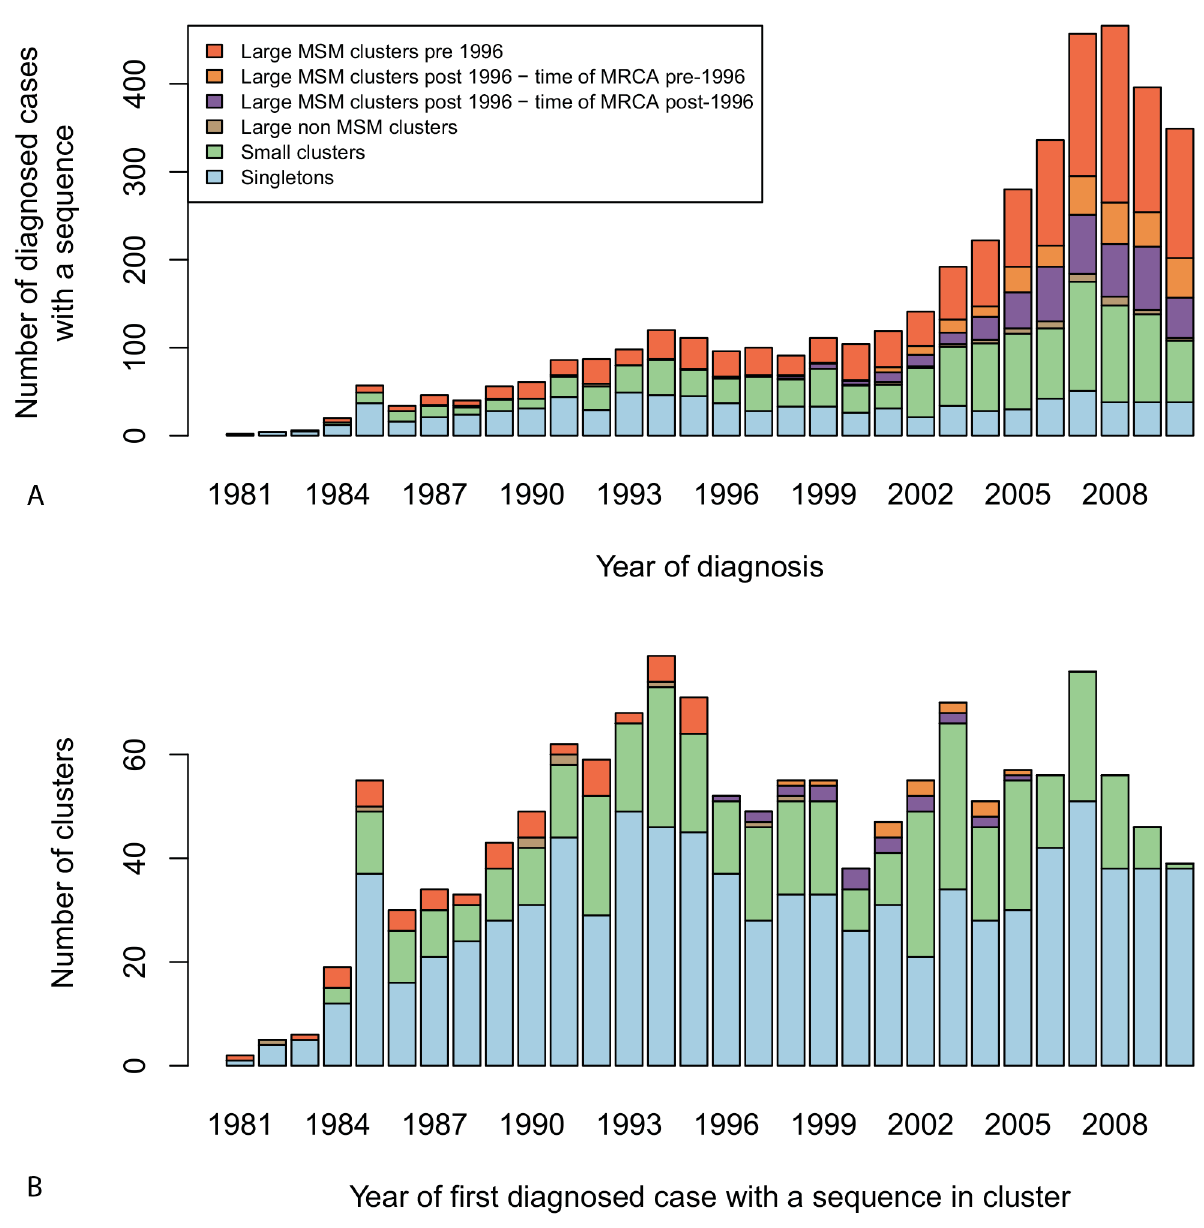
Fig 4. Diagnosis and growth of transmission clusters over time. Cluster types within the phylogenetic tree are defined as follows. Singletons (in blue) are clusters of size 1, or cases whose sequence solely clustered with sequences from the Los Alamos HIV Sequence Database. Small clusters (in green) comprise sequences from 2 – 9 ATHENA patients. Large clusters comprise sequences from ten or more patients in the ATHENA cohort. Amongst those, non- MSM-dominant clusters (in brown) contain a majority of sequences from non-MSM patients, whilst MSM-majority clusters contain a majority of sequences from MSM patients. Among large MSM-majority clusters, pre-1996 clusters (in dark orange) are defined as those in which the first diagnosed patient in the cluster was diagnosed before 1996, and post-1996 clusters are defined as those in which all patients in the cluster were diagnosed in or after 1996.